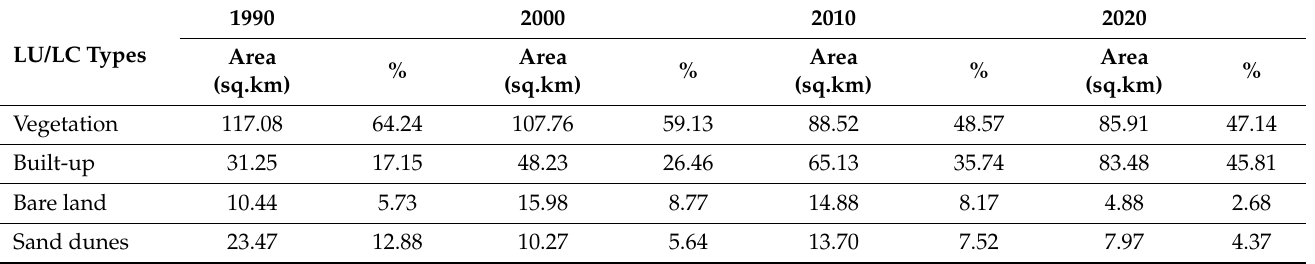
Table 3. A summary of area coverage of LULC classes over the 30 year study period.